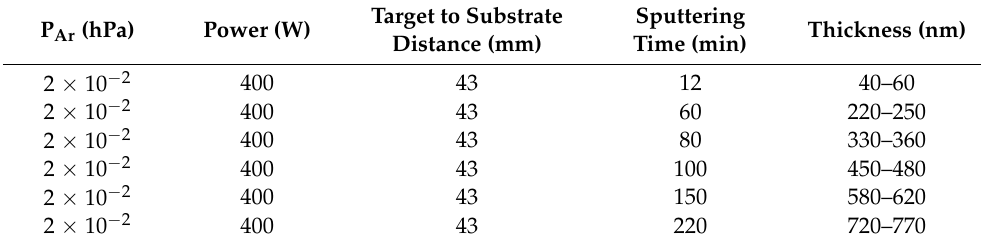
Table 1. List of the deposition parameters: P Ar vacuum level expressed in argon pressure, power of the device, target to substrate distance, sputtering time and the measured thickness of the